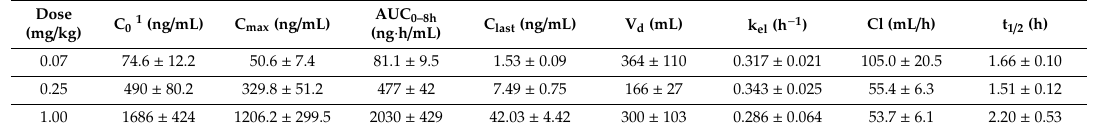
Table 2. Pharmacokinetic parameters of